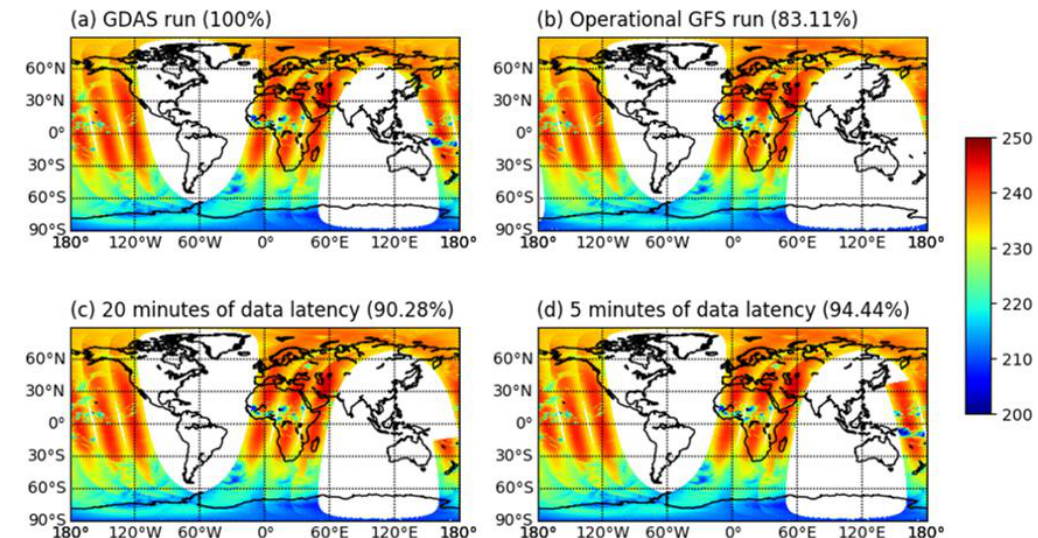
Figure 1. Spatial coverage of Cross-Track Infrared Sounder (CrIS) channel 99 (corresponding to the channel wavenumber of 711.15 cm -1 ) brightness temperatures for ( a ) the global data assimilation system (GDAS) run, ( b ) the operational Global Forecast System (GFS) run, ( c ) the GFS run with the 20-min data latency, and ( d ) the GFS run with the 5-min data latency on 0000UTC 1 July 2018. Data ratio against the CrIS data for the GDAS run is described in parenthesis.